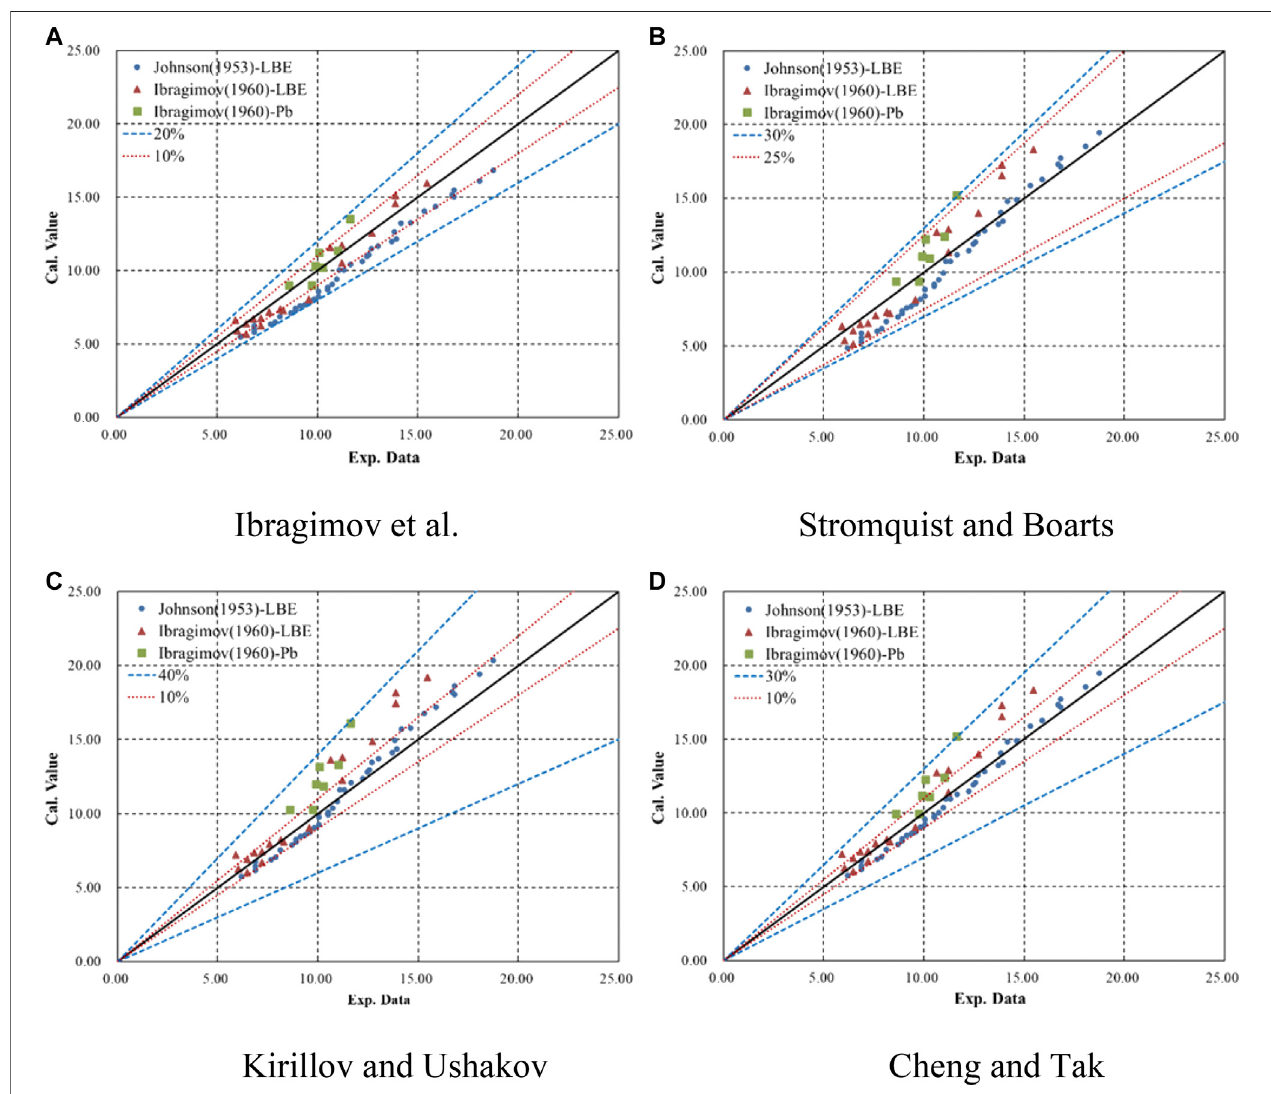
FIGURE 6 | Deviations of other relations from experimental LLM data in the literature.